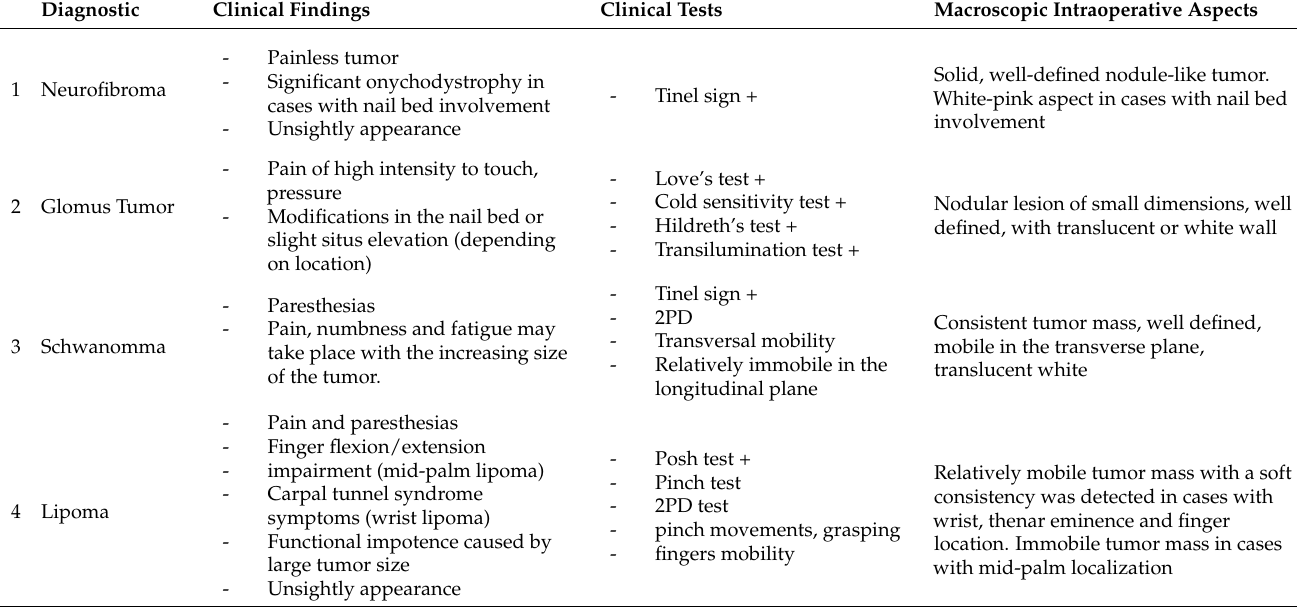
Table 2. Clinical and macroscopic aspects of the tumors in the study group.